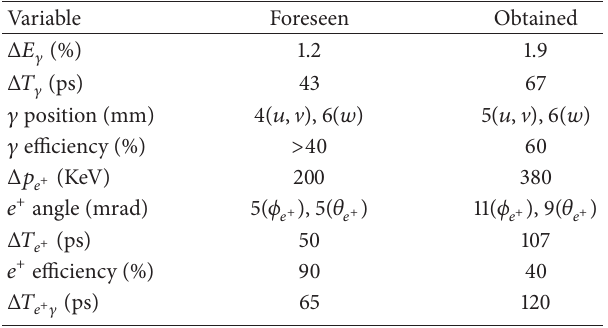
Table 3: Foreseen and measured resolutions (sigma’s) for the MEG